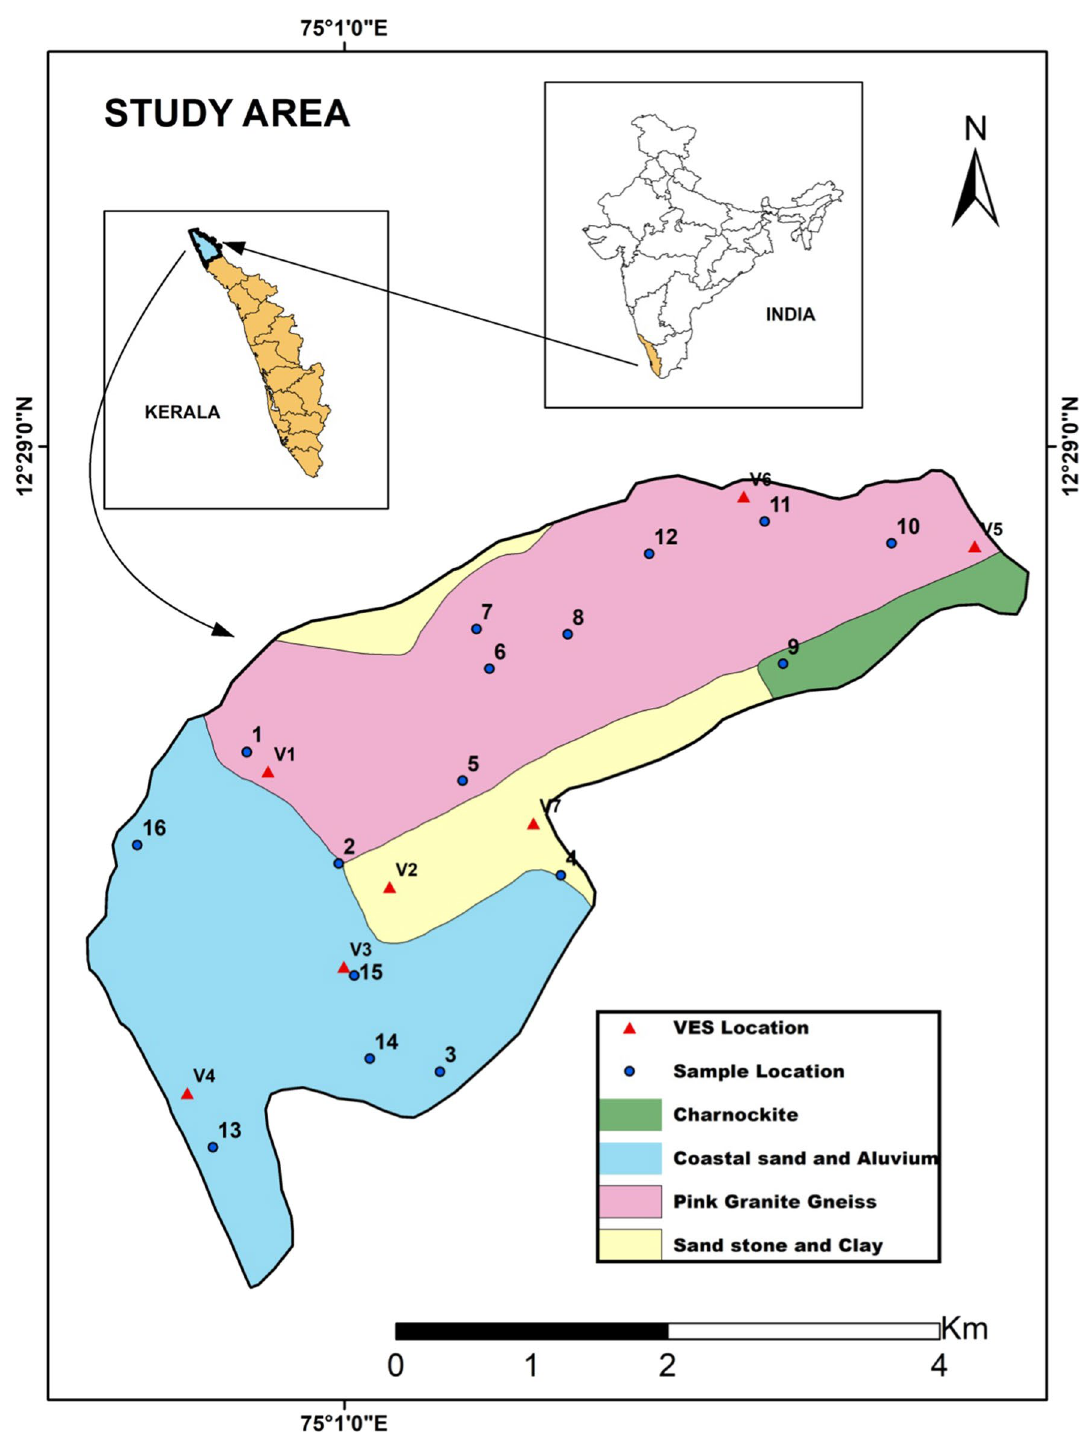
Fig. 1 Location map of the study